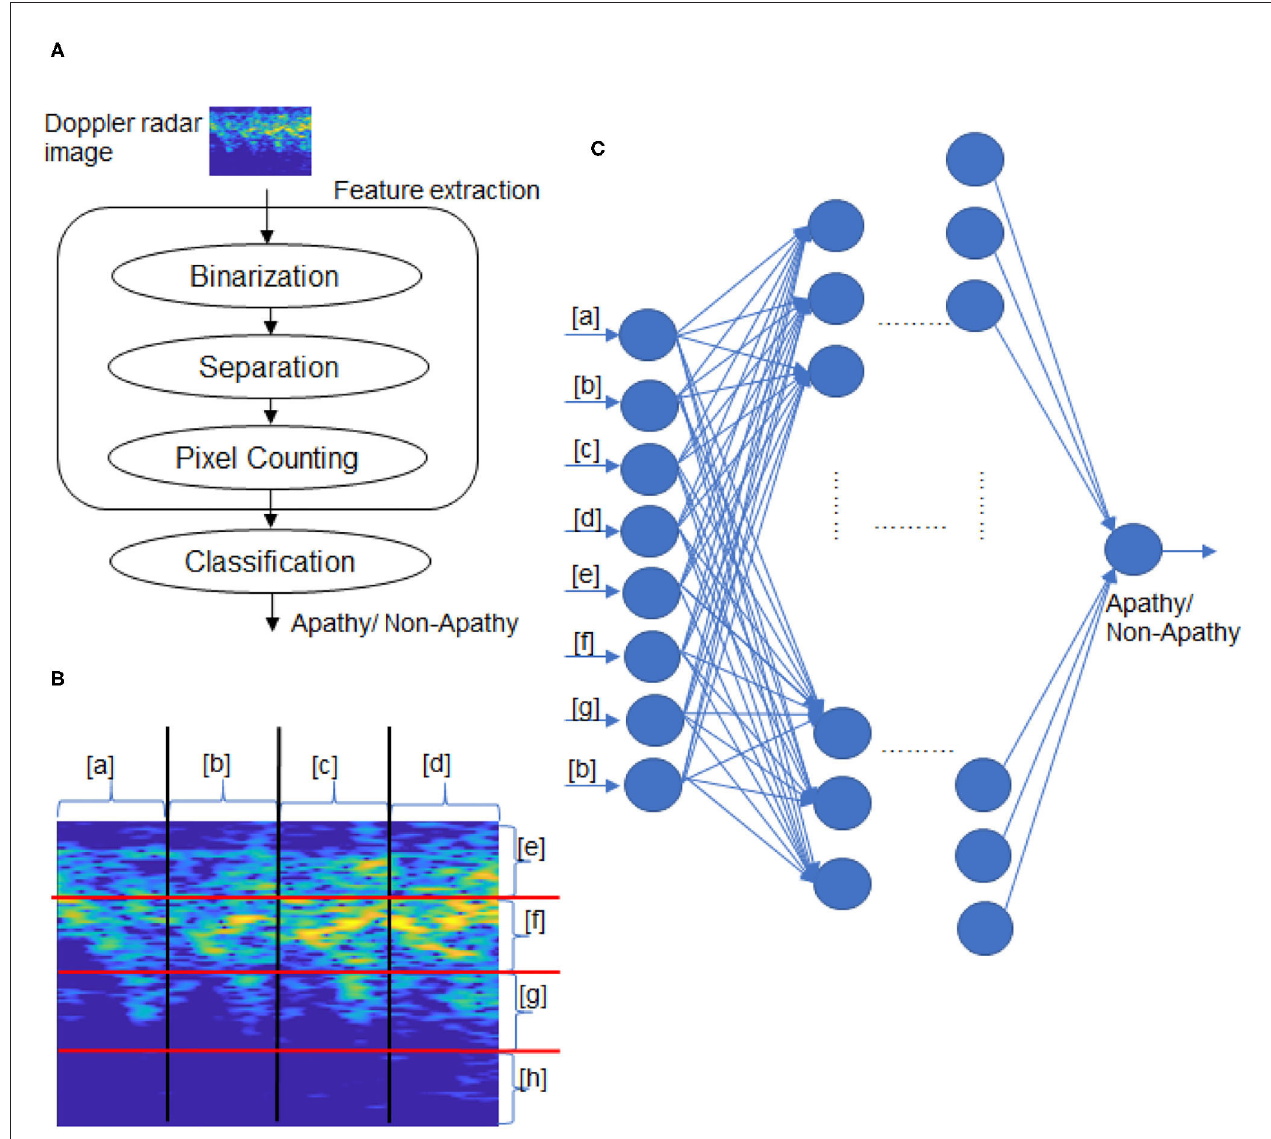
FIGURE 2 | Overview of proposed method. (A) Classification flow, (B) Doppler radar image separation, (C) Classification by